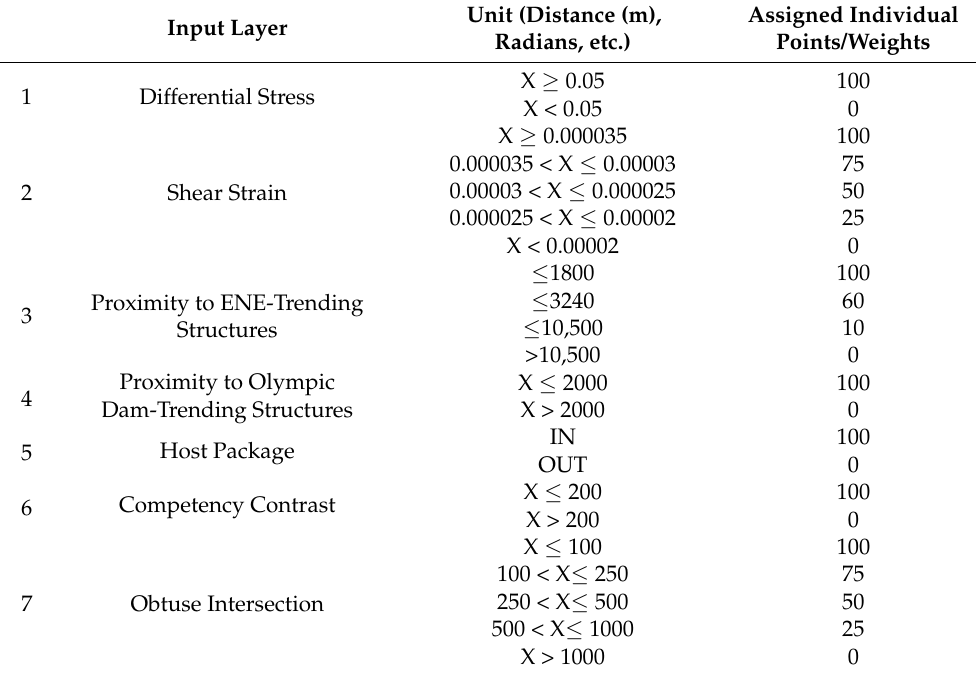
Table 2. IOCG targeting index inputs and their relative